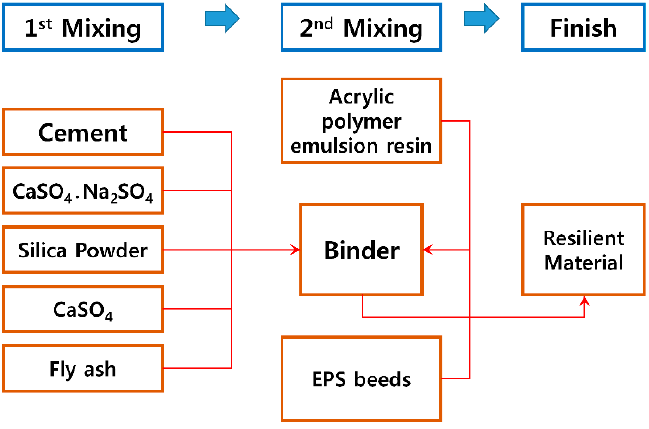
Figure 3. Experiment process of the place-type resilient material.